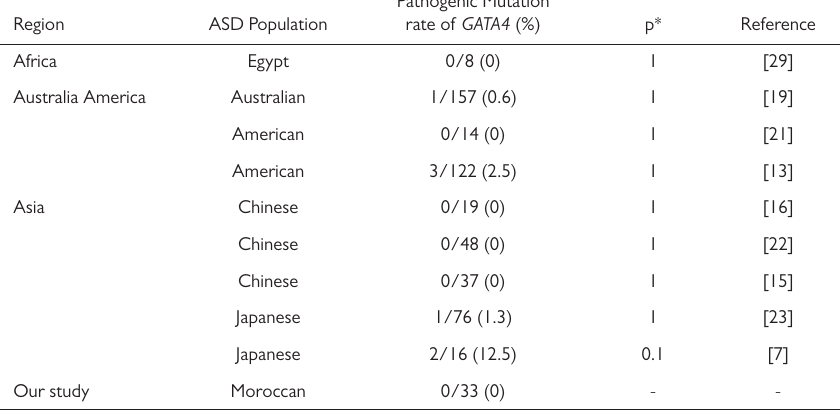
Table 4. GATA4 mutation rates in tetralogy of Fallot (TOF) throughout the